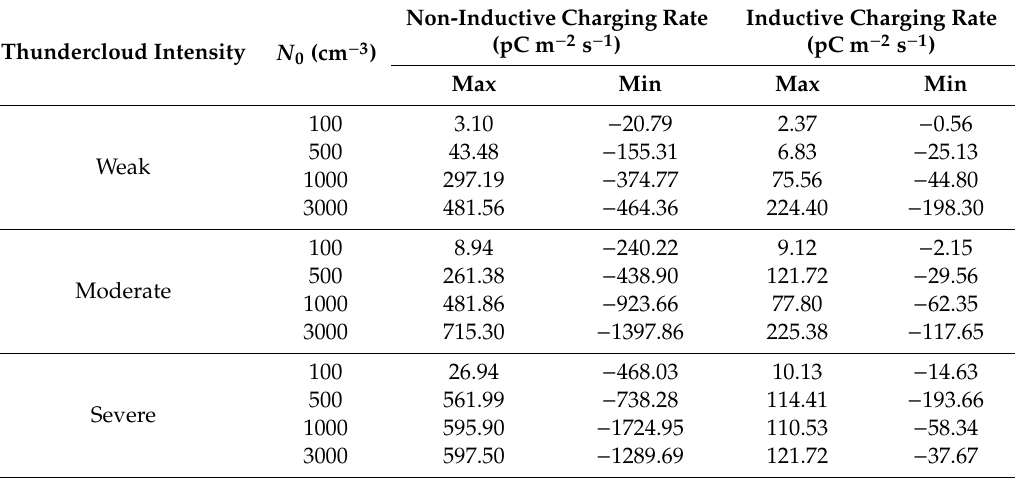
Figure 11. The evolution of the non-inductive charging rate; black solid line represents the isotherm ( − 40 and − 15 °C, and to 0 °C); ( a – d ) in weak thundercloud ((a) N 0 = 100 cm − 3 ; (b) N 0 = 500 cm − 3 ; (c) N 0 = 1000 cm − 3 ; (d) N 0 = 3000 cm − 3 ); ( e – h ) in moderate thundercloud; ( i – l ) in severe thundercloud. Table 1. The non-inductive charging rate and inductive charging rate. Thundercloud